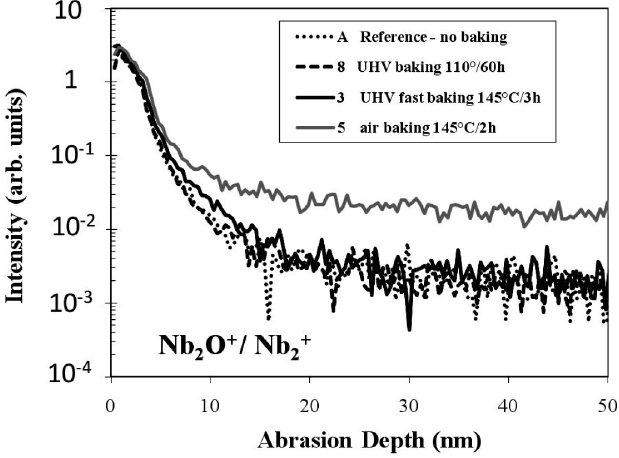
FIG. 2. Interstitial oxygen profiles in Nb samples by SIMS analyses. No difference before (sample A) and after baking in oxygen-free atmosphere (samples 8 and